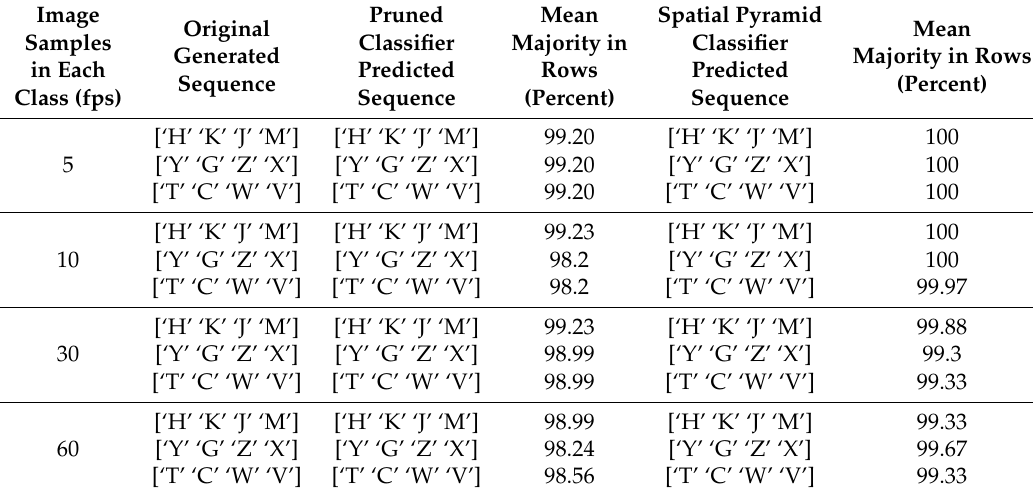
Table 10. Proposed sequencer performance